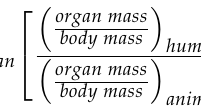
Table 3. Organ mass of mice and humans and the coefficient factor from mouse to human. Organ Mass in Humans (g) Organ Mass in Mice (g) Coefficient from Mouse to Human Organs Male